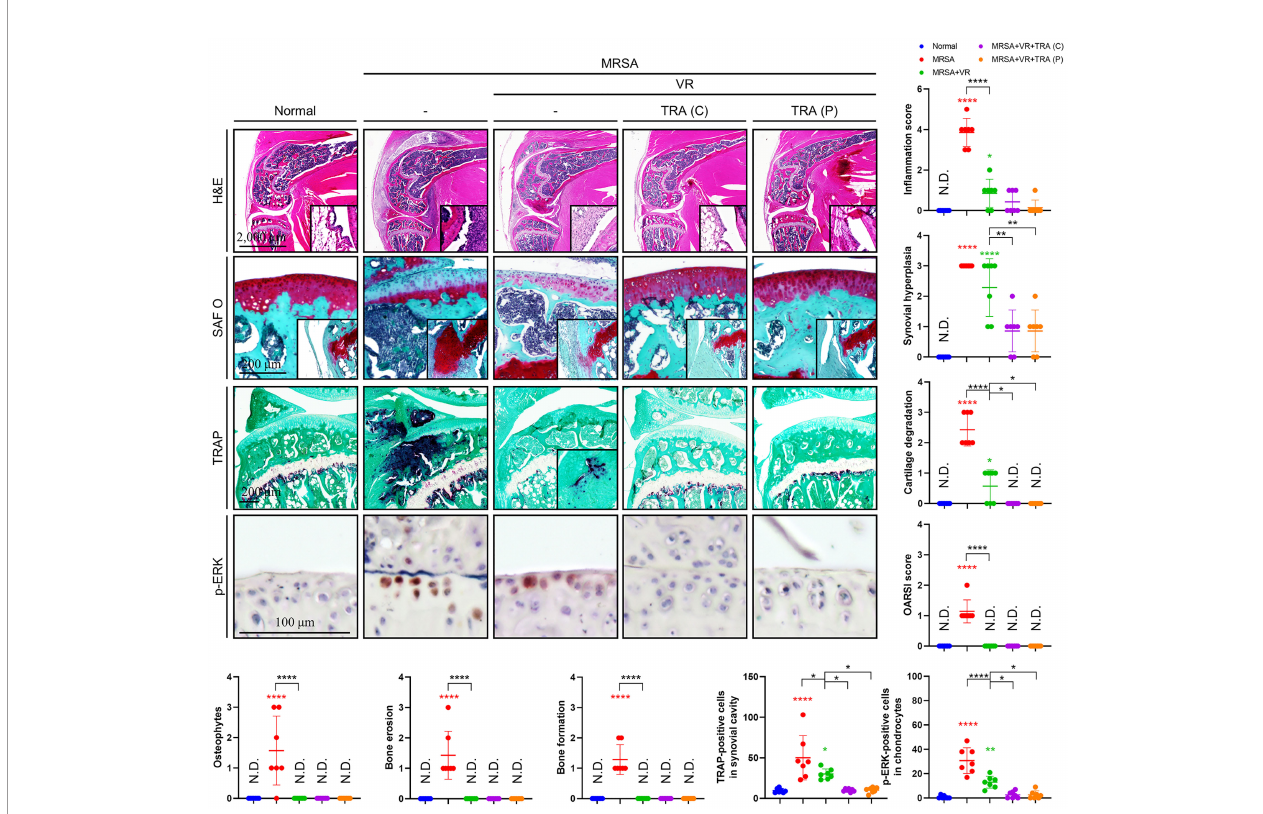
FIGURE 6 | Adjuvant treatment of trametinib provided chondroprotection and inhibited in fl ammatory osteolysis. C57BL/6 mice received intraarticular knee joint injections of MRSA (1×10 6 CFU/10 m L) ( n = 7 per group). To test combination antibiotic treatment alone (abbreviated VR), vancomycin (30 mg/kg) and rifampin (20 mg/kg) were administered subcutaneously for 6 days after MRSA infection. To assess the viability of concurrent Trametinib supplementation [abbreviated TRA (C)], mice were given vancomycin (30 mg/kg) and rifampin (20 mg/kg) subcutaneously for 3 days and conjugated with a three-day trametinib regimen (1 mg/kg) beginning on post-injection day four. Finally, to test the utility of Trametinib at the end of antibiotic therapy [abbreviated TRA (P)], Vancomycin (30 mg/kg) and rifampin (20 mg/ kg) were subcutaneously injected for 6 days after MRSA infection. On post-injection day seven, trametinib (1 mg/kg) was subcutaneously injected for three days. All models were sacri fi ced at 14 days post-MRSA injection. The in fl ammation score, synovial hyperplasia, cartilage degradation, OARSI score, osteophytes, bone erosion, bone formation, TRAP-positive cells, and p-ERK-positive cells were measured using H&E-, SAF O-, and TRAP-stained images (Scale bar: 2,000, 200, and 100 m m). Error bars show means ± SD. One-way ANOVA with Tukey ’ s post hoc analysis was used to assess statistical signi fi cance when compared to the normal group or MRSA group or MRSA+VR group (* p <0.05 or ** p < 0.01 or *** p < 0.001 or **** p < 0.0001; N.D., not